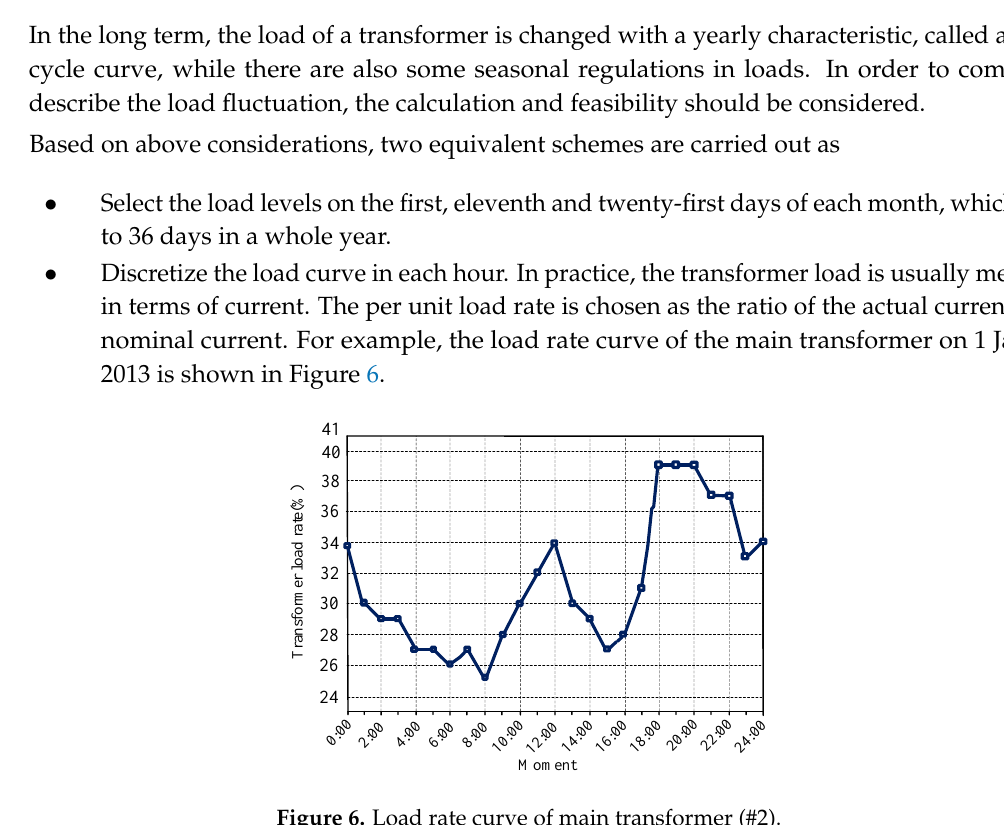
Figure 6. Load rate curve of main transformer (#2).